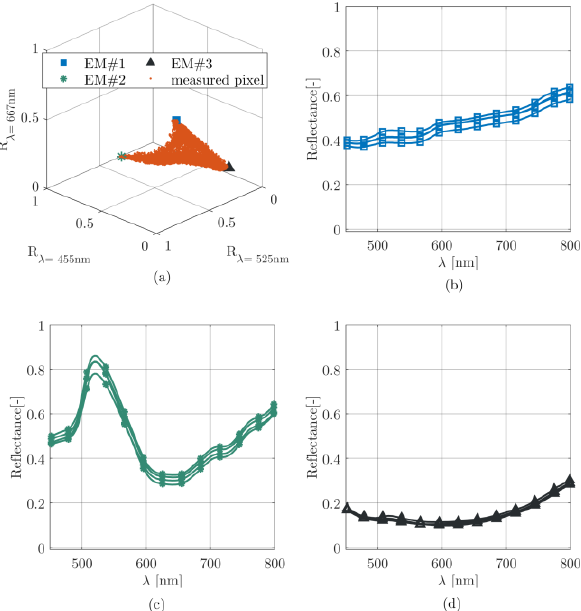
Figure 5. EM extracted by NFINDR algorithm, (a) example of pattern A measured pixels and EMs; extracted EMs for A-D